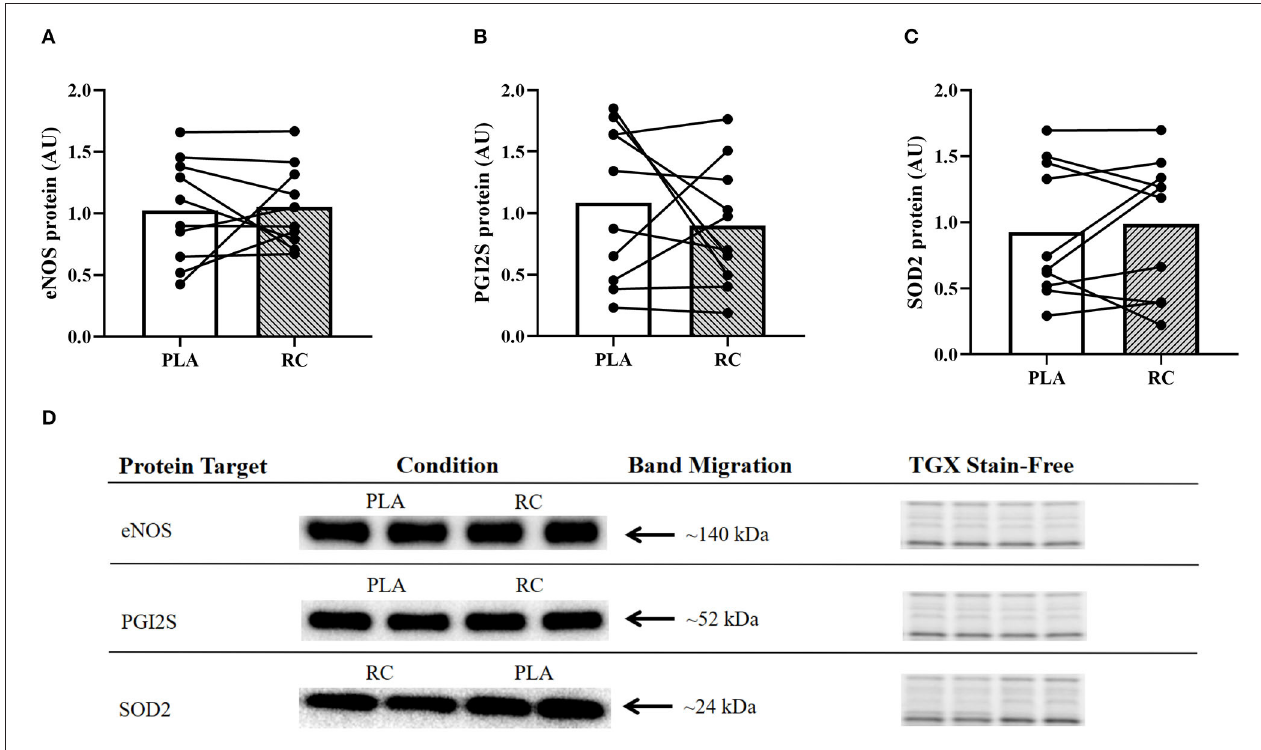
FIGURE 4 | Expression of proteins associated with vasodilatory capacity in skeletal muscle from early post-menopausal women following 2 weeks of twice daily supplementation with placebo (PLA) or fermented red clover extract (RC) ( n = 10). (A) Endothelial nitric oxide synthase (eNOS), (B) prostacyclin synthase (PGI 2 S), and (C) superoxide dismutase 2 (SOD2). (D) Representative western blots and the corresponding TGX stain-free